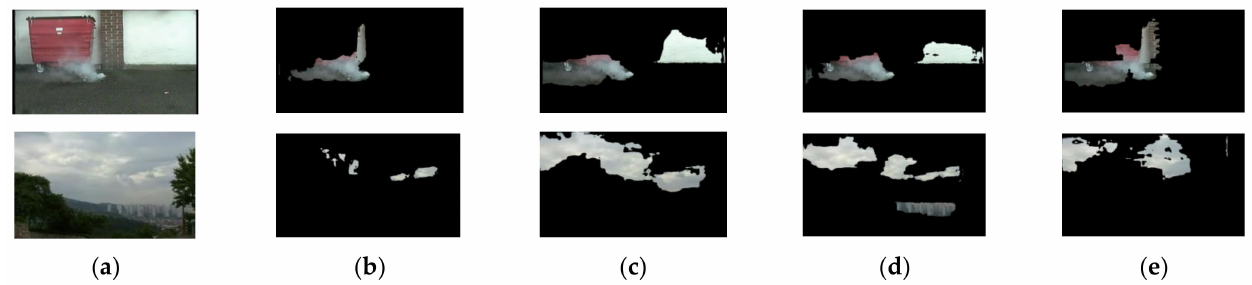
Figure 8. Anti-interference test results: ( a ) input frame; ( b ) ours;( c ) FCN; ( d ) RANet; ( e ) DeepLab